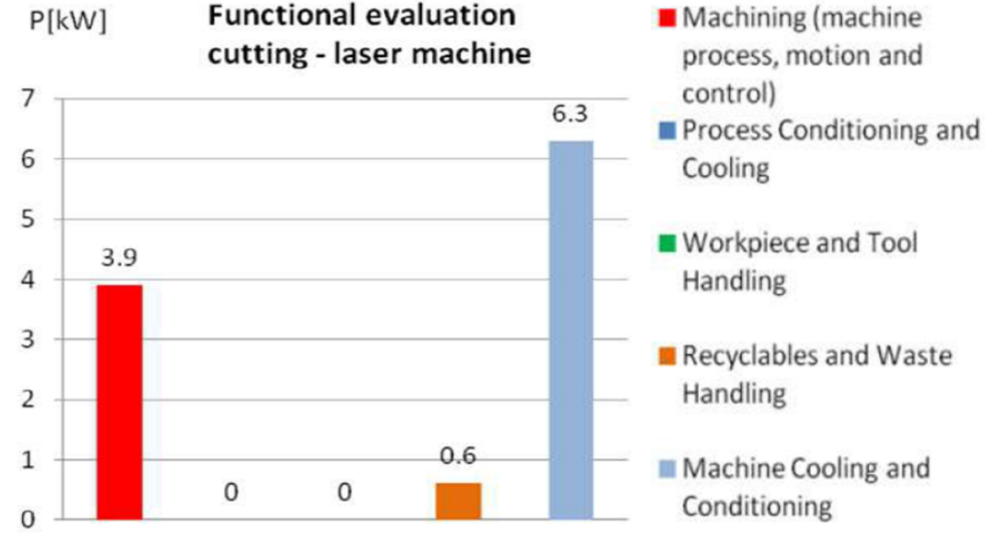
Figure 5. Functional analysis according to ISO 14955 with RLW